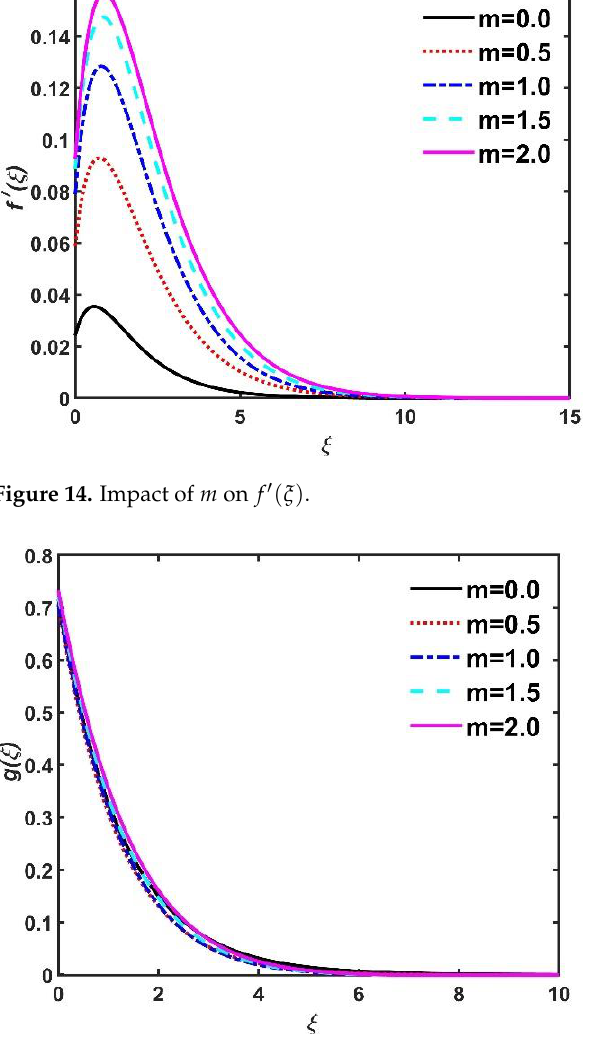
Figure 15. Impact of 𝑚 on 𝑔(𝜉) .